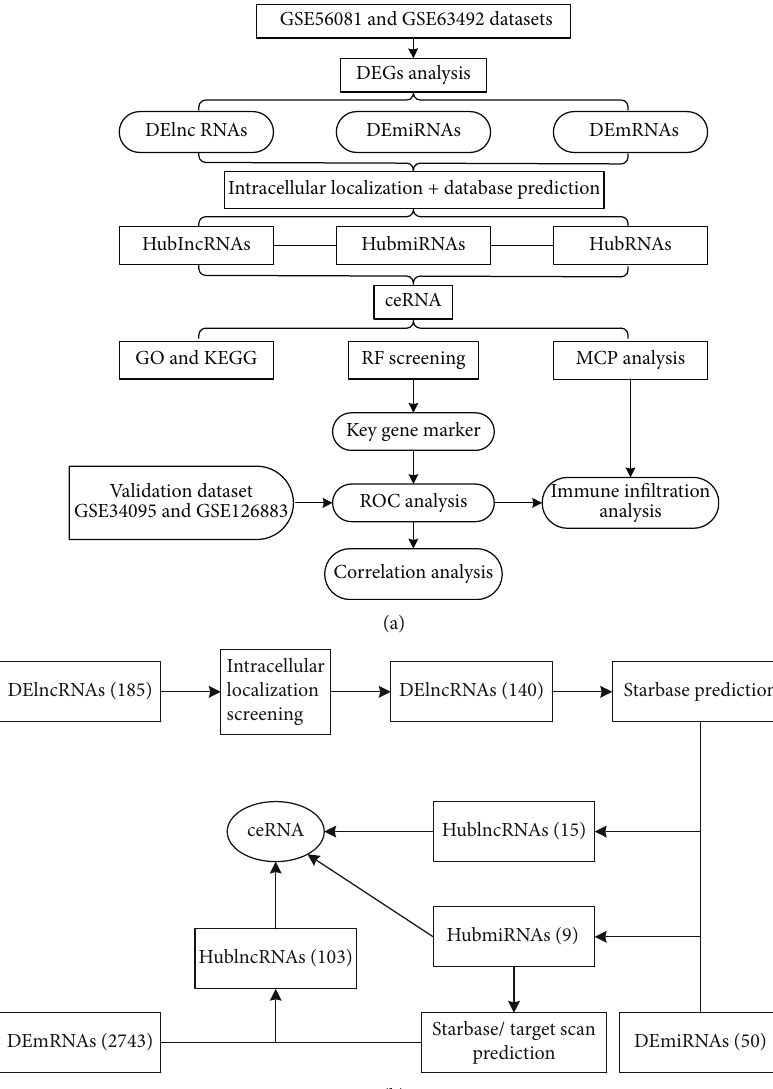
Figure 2: Flow chart of research analysis. (a) Whole process content of the study. (b) Process content of ceRNA network construction. DEGs: di ff erentially expressed genes; GO: Gene Ontology; KEGG: Kyoto Encyclopedia of Genes and Genomes; RF: random forest; ROC: receiver operating characteristic